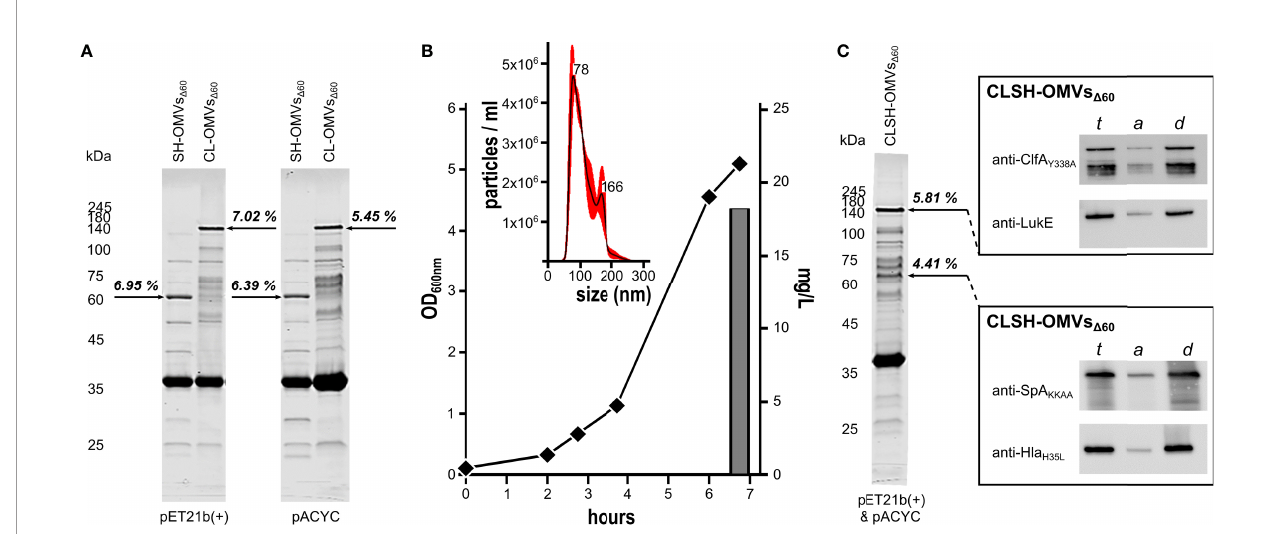
FIGURE 1 | Expression of Staphylococcal antigen fusions in OMVs from E. coli BL21(DE3) D 60. (A) OMVs from E. coli BL21(DE3) D 60 strains expressing heterologous antigen fusions SpA KKAA -Hla H35L (SH-OMVs D 60 ) and ClfA Y338A -LukE (CL-OMVs D 60 ) as lipoproteins using either pET21b(+) or pACYC as plasmid backbone were puri fi ed from culture supernatants as described in Materials and Methods. Aliquots (10 m g of total OMV proteins) were analyzed by SDS-PAGE. (B) Growth curve, OMV production yield and particle size analysis of CLSH-OMVs D 60 grown in a 3-L bioreactor (see Materials and Methods for details). The size of CLSH-OMVs D 60 was determined using a NanoSight NS300 (Malvern Panalytical). The graph shows the average of three independent measurements and standard error as calculated by